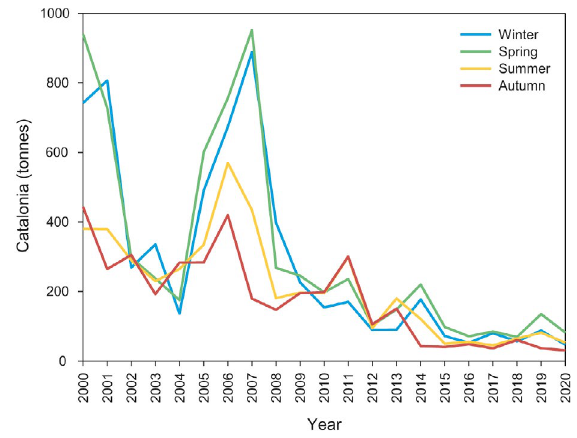
Fig. 3. – Seasonal landings of blue whiting on the coast of Catalonia from 2000 to